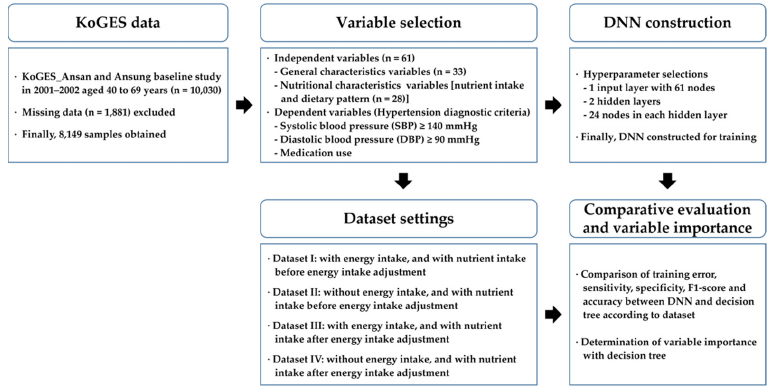
Figure 1. A flowchart for research